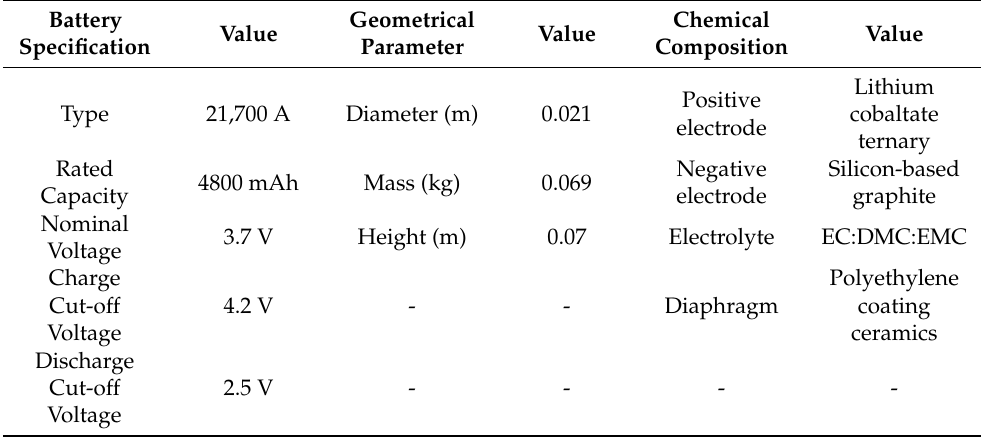
Table 2. Electrochemical and geometric parameters of Panasonic 21,700 lithium-ion